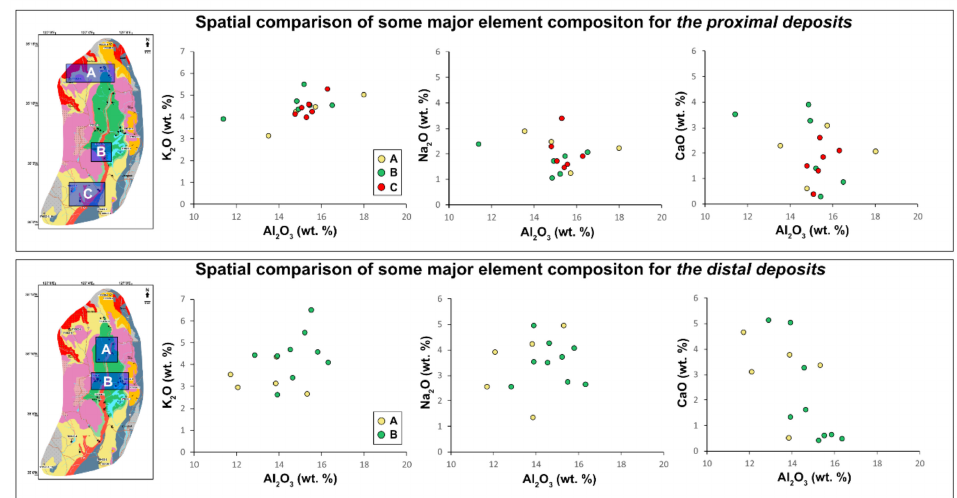
Figure 8. Spatial comparisons of some major element composition for the proximal and distal deposits. Each sample group shows similar range of major element composition, respectively.